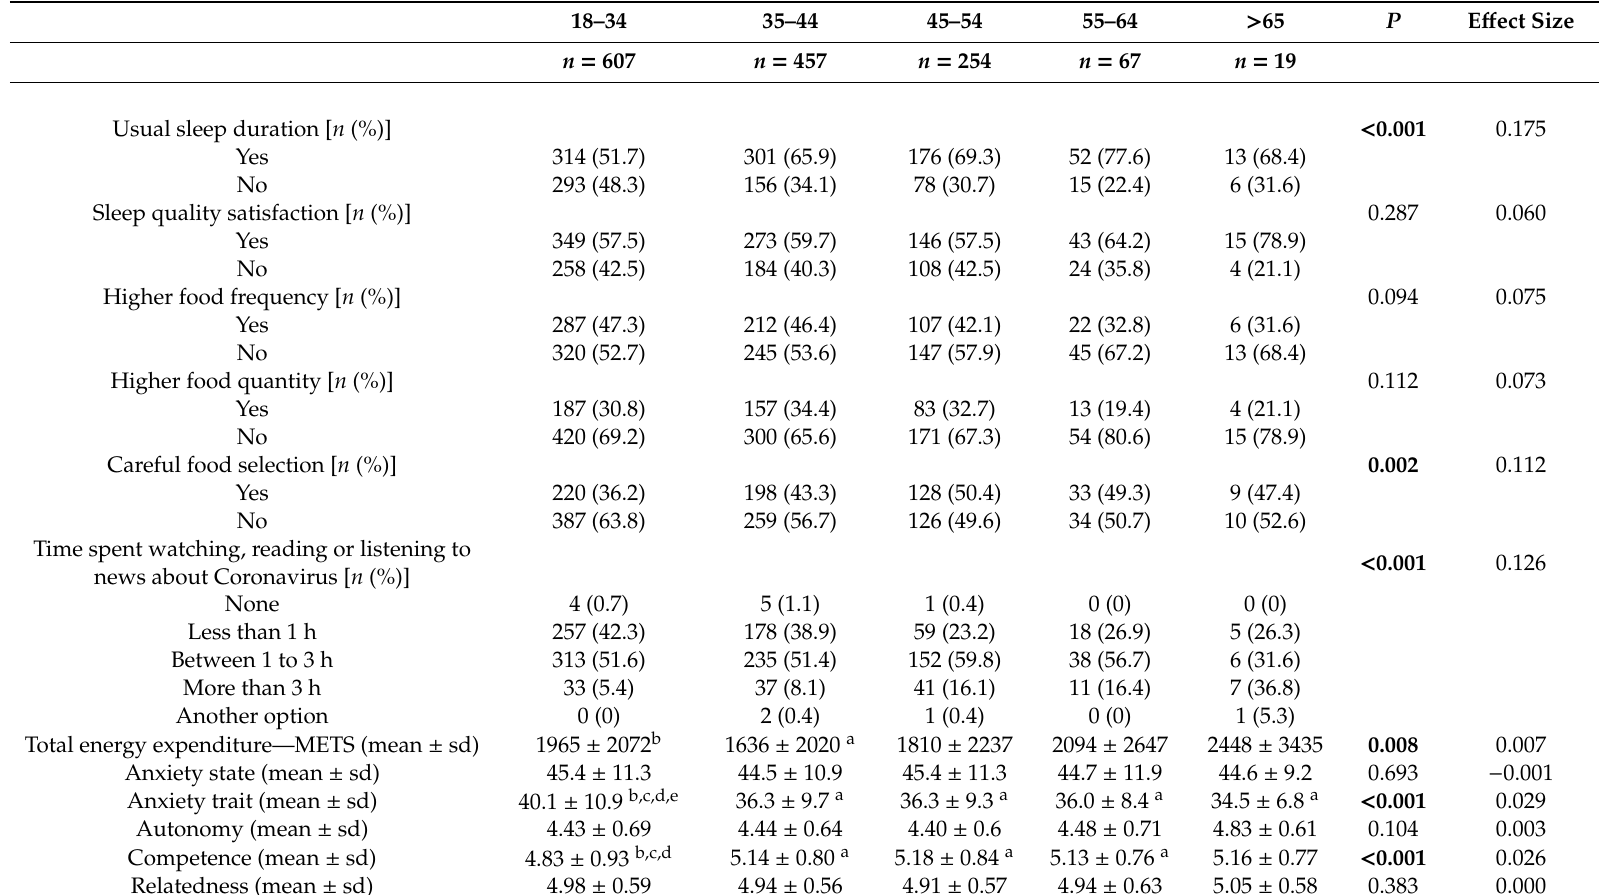
Table 3. Age-related distribution according to sample characteristics ( n =